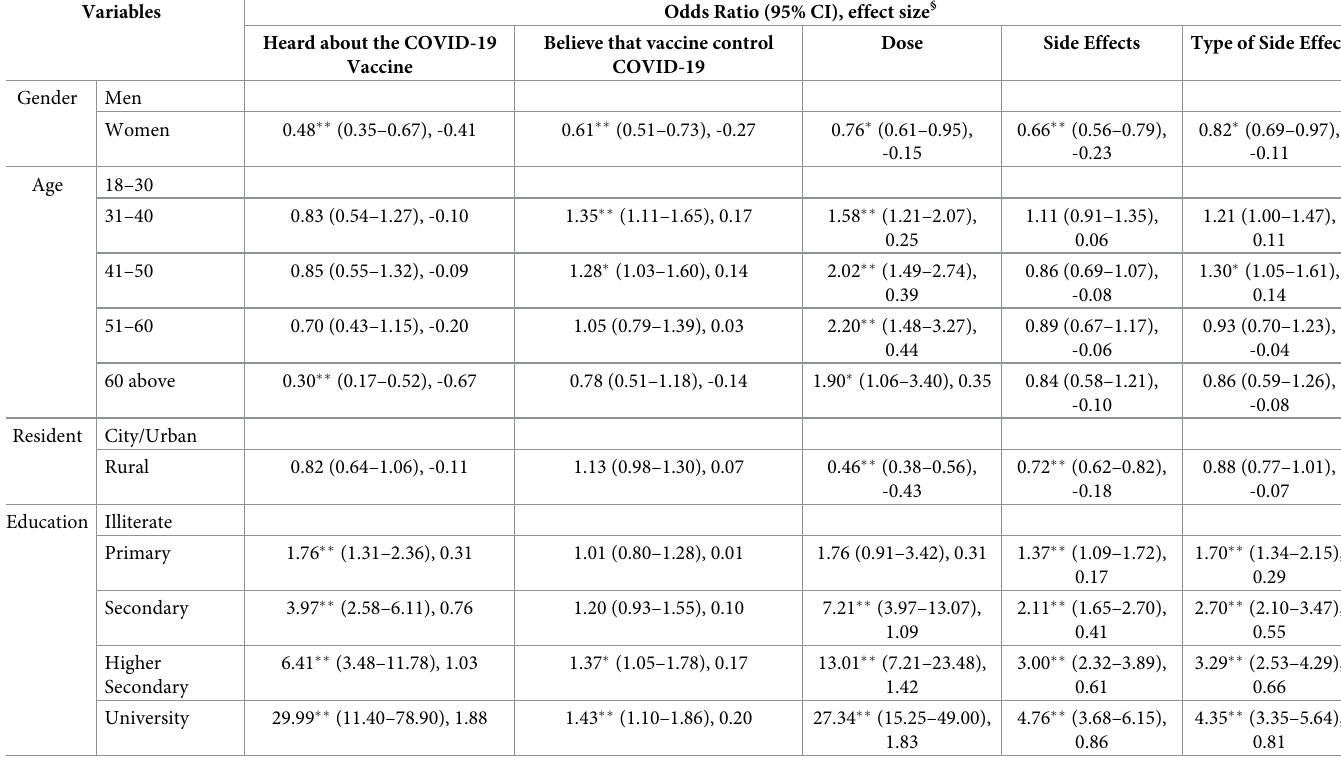
Table 4. Logistic regression on respondents’ knowledge of COVID-19 vaccination.